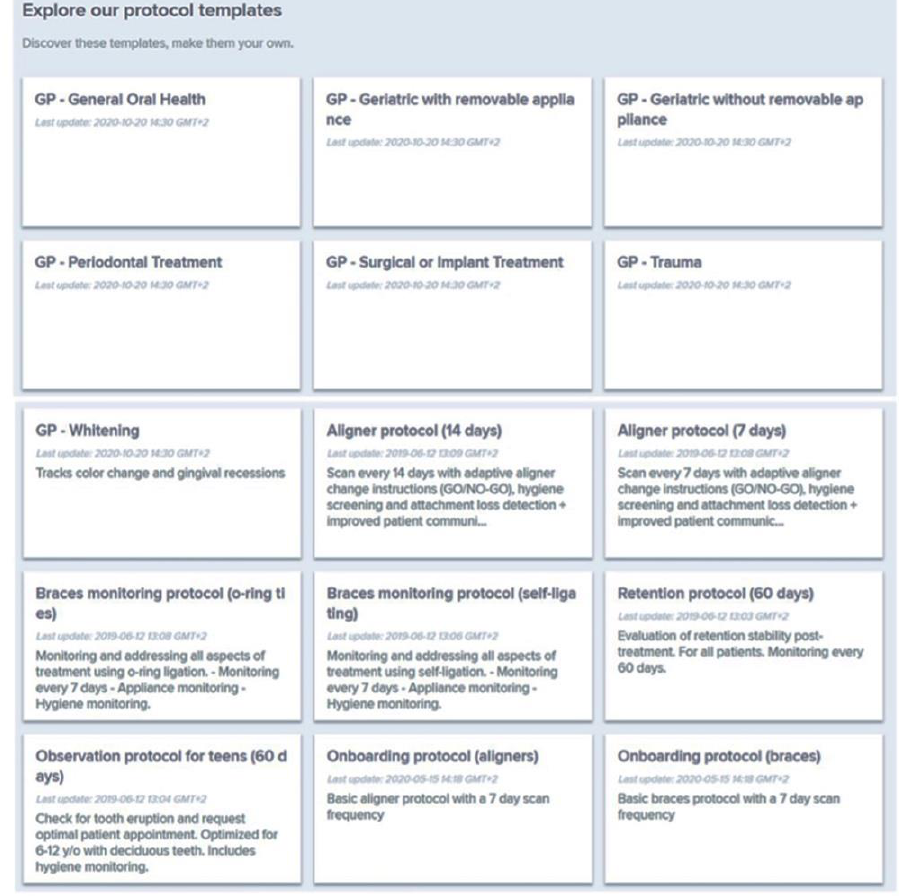
Figure 2. Protocols template in the DM system. The DM system can be used to monitor different kinds of treatments (not only orthodontics): prosthetic dentistry, surgery, traumatic injury, periodontal treatments, dental bleaching, oral hygiene, and general oral health.